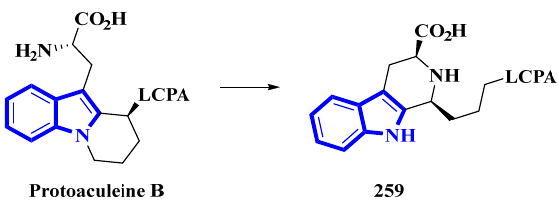
Figure 14. Reappraised structure of protoaculeine B 259 .